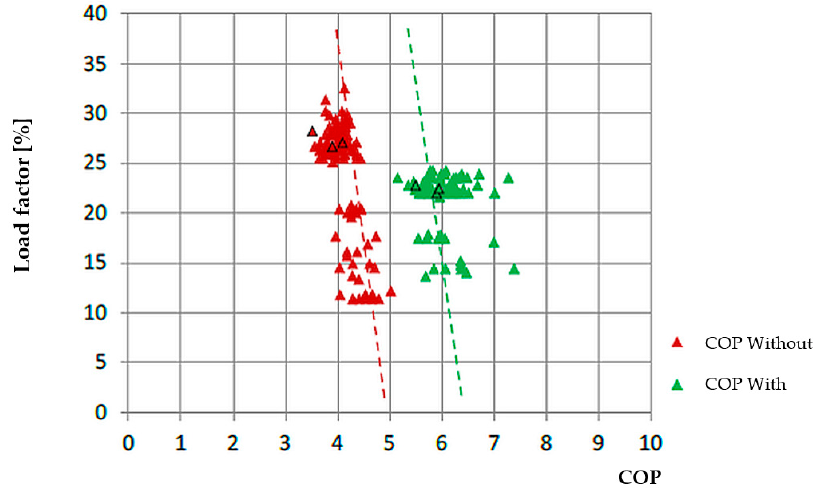
Figure 8. Determination of Coe ffi cient of Performance (COP) “with” and “without” of refrigeration systems in service.